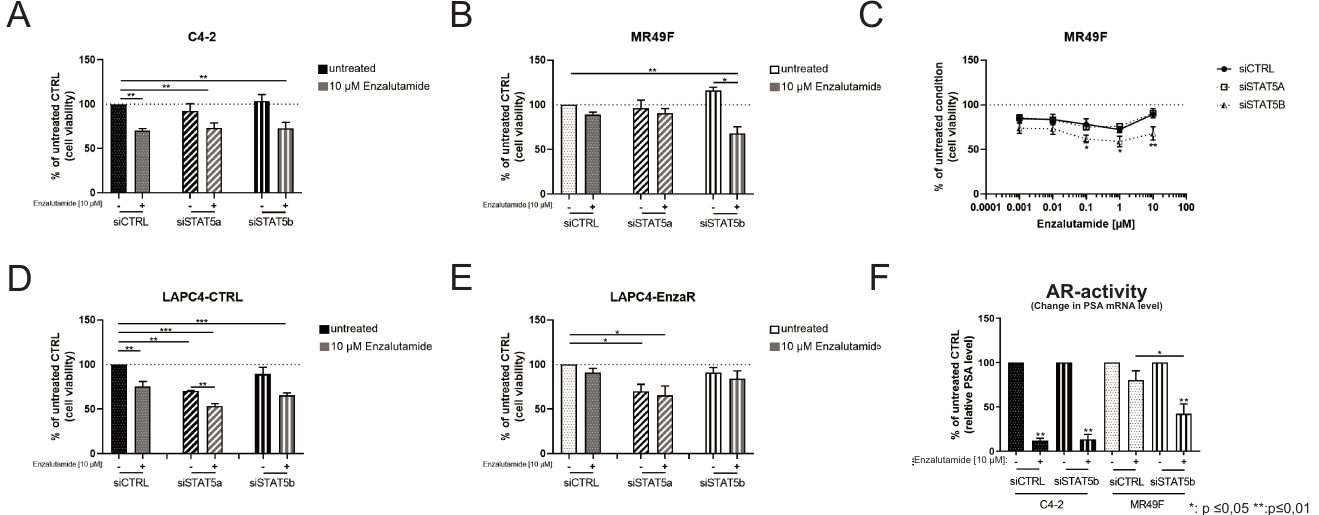
Fig 5. Influence of STAT5a and STAT5b knockdown on cell viability in the presence and absence of enzalutamide. (A+B) Cell viability of C4-2 cells (A) and MR49F cells (B) after knockdown of STAT5a or STAT5b in the presence and absence of 10 μ M enzalutamide was assessed by MTT assays. Data were plotted as mean ± s.e.m. of three independent experiments. (C) Dose-response curve of MR49F cells with knocked-down STAT5a and STAT5b treated with enzalutamide (0,001 to 10 μ M). Cell viability was assessed by MTT assays. Data is shown as mean ± s.e.m. of three independent experiments. (C+D) Cell viability of LAPC4-CTRL cells (D) and LAPC4-EnzaR cells (E) after knockdown of STAT5a or STAT5b in the presence and absence of 10 μ M enzalutamide was assessed by MTT assays. Data is plotted as mean ± s.e.m. of three independent experiments. ( � : p � 0.05 �� :p � 0.01 ��� : p � 0.001) (F) PSA/KLK3 regulation as an indicator for AR activity in C4-2 cells and MR49F cells after siCTRL and siSTAT5b pool transfection in the presence and absence of 10 μ M enzalutamide was measured by qPCR. Data is shown as mean as mean ± s.e.m. of three independent experiments ( � : p � 0.05 �� :p � 0.01 ��� : p � 0.001).